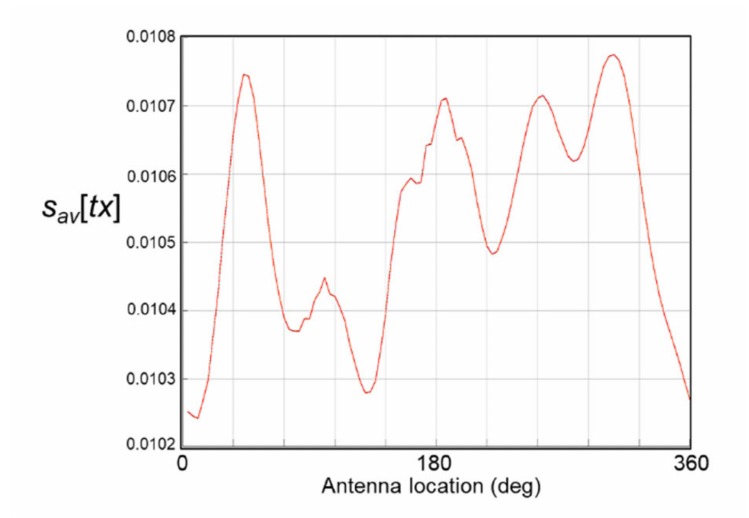
Figure 7. Magnitude values computed from Equation